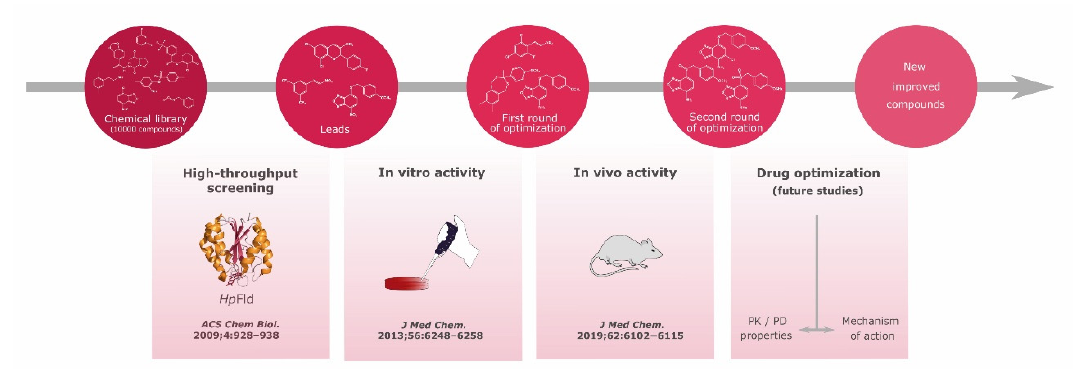
Figure 4. The steps followed and planned in the discovery of flavodoxin inhibitors as new therapies against Hp infection.